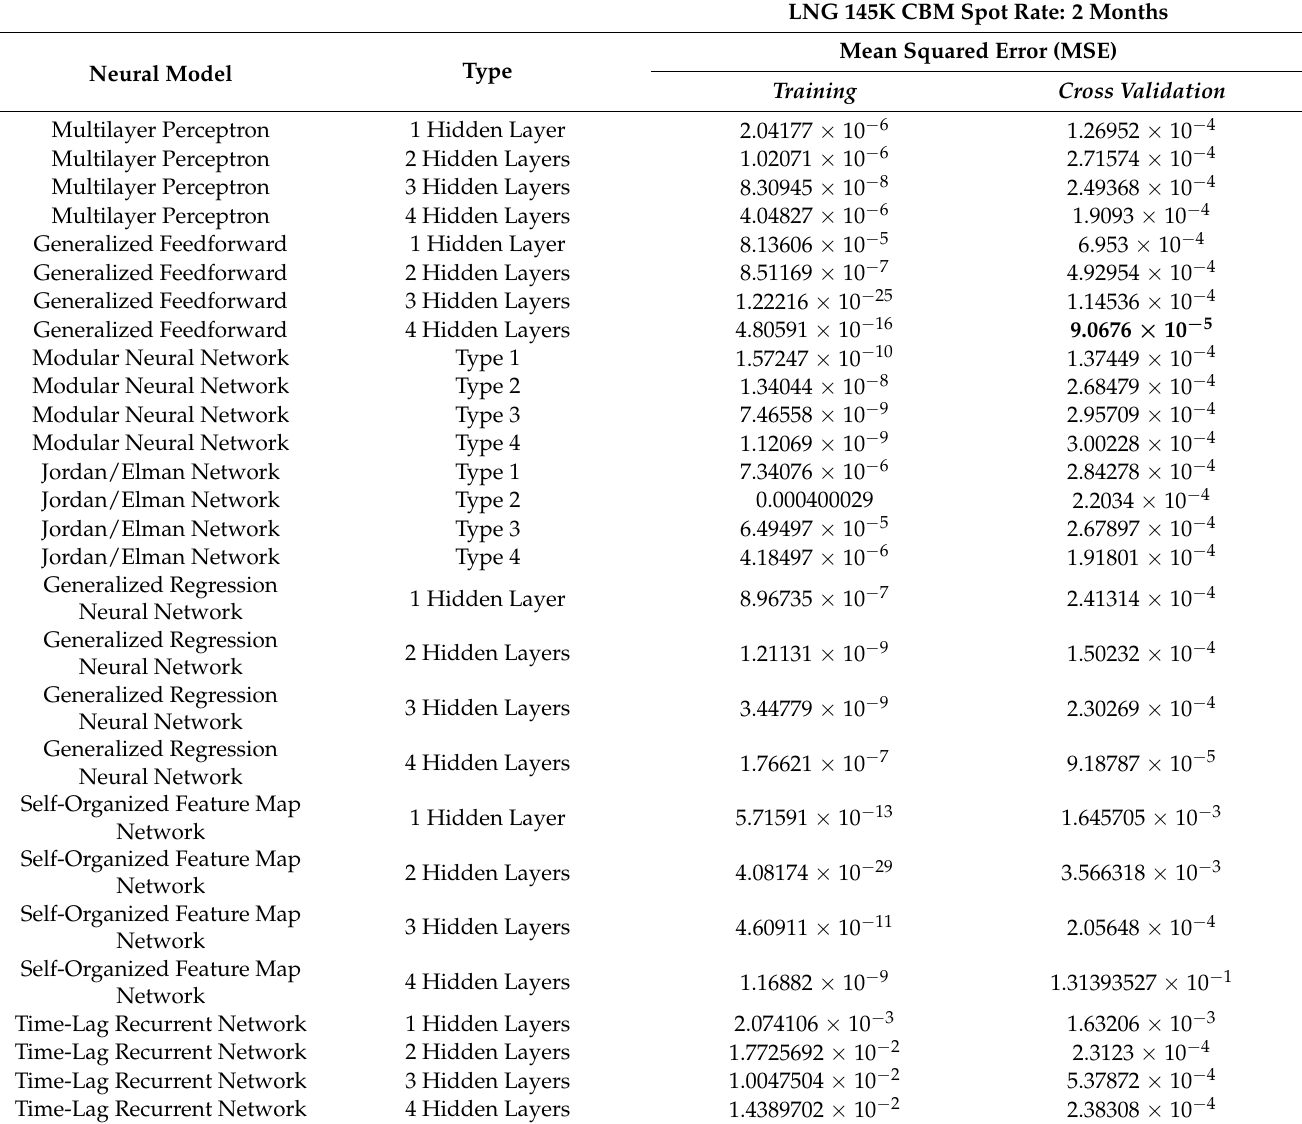
Table 7. Results of forecast for LNG 145K CBM spot rate: 2 months. The best score is shown in bold.